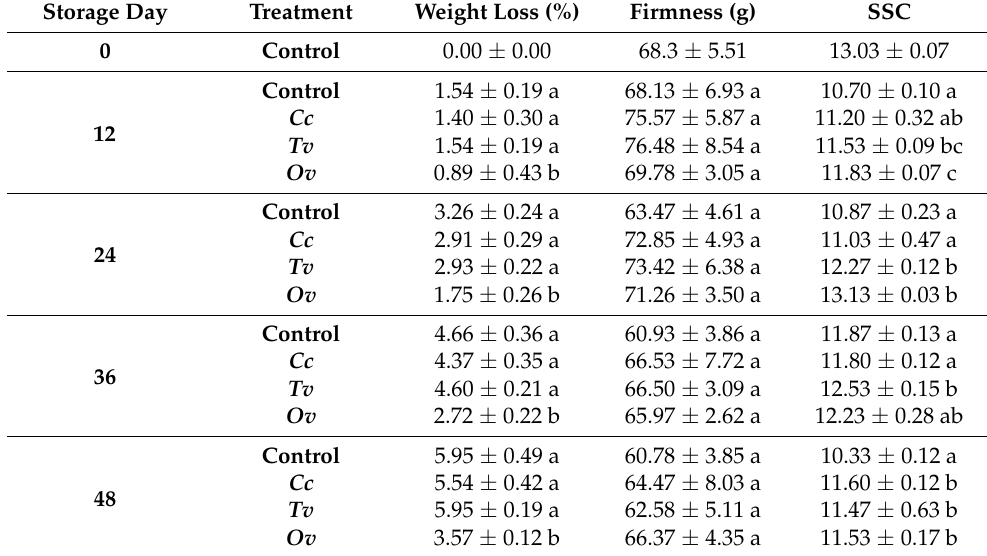
Table 3. Effects of Cymbopogon citratus ( Cc ), Thymus vulgraris ( Tv ), and Origanum heracleoticum ( Oh ) essential oil vapor treatments on weight loss, firmness, and solid soluble content (SSC) of strawberry fruit. Storage